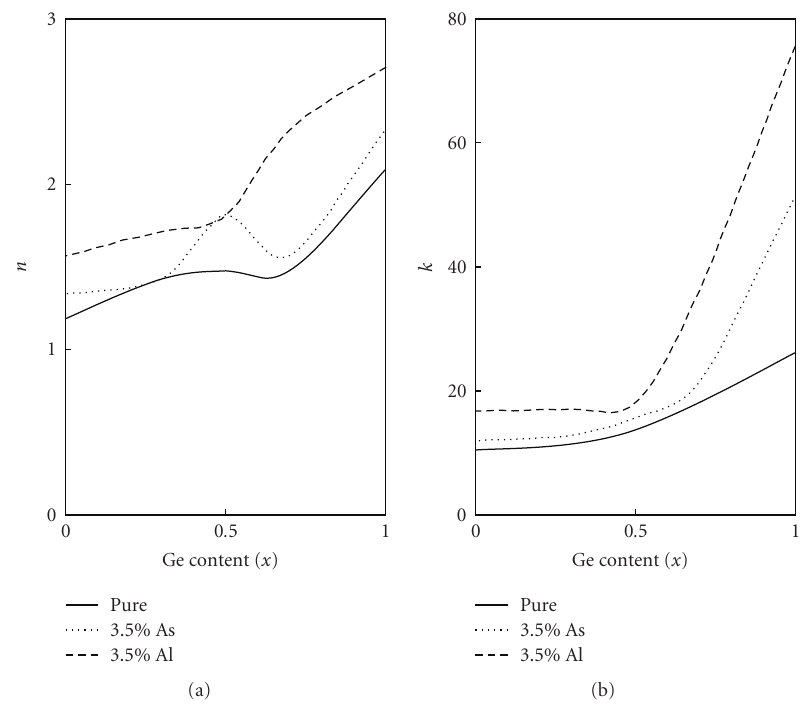
Figure 5: Variation of (a) n and (b) k with Ge content for pure and doped (3.5%As and 3.5%Al) for a-Ge x Si 1 − x :H films.